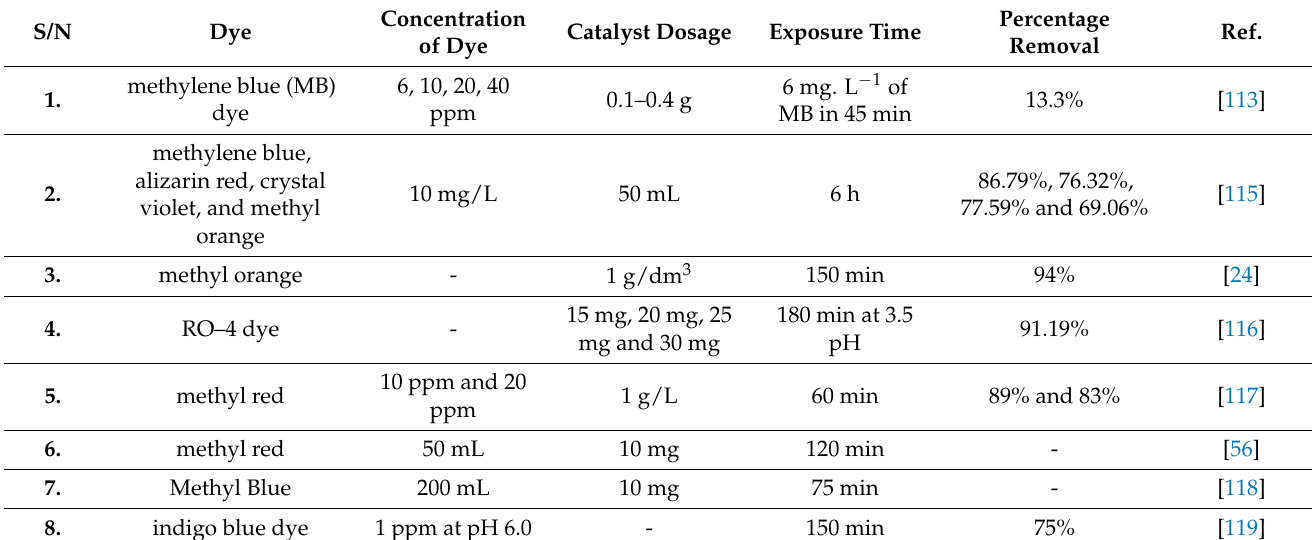
Table 3. Photocatalytic effect of Titanium dioxide nanoparticles using different plant